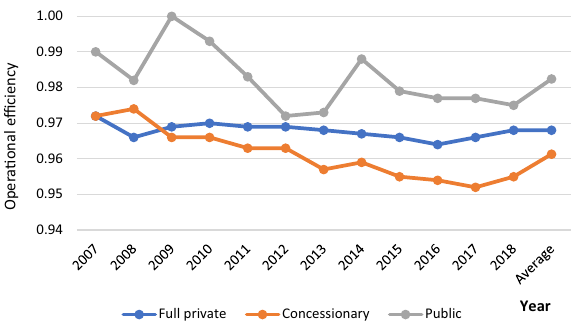
Fig. 2 Evolution over time of operational ef fi ciency of Chilean full private, concessionary, and public water utilities. The trend in operational ef fi ciency based on the type of water utility.